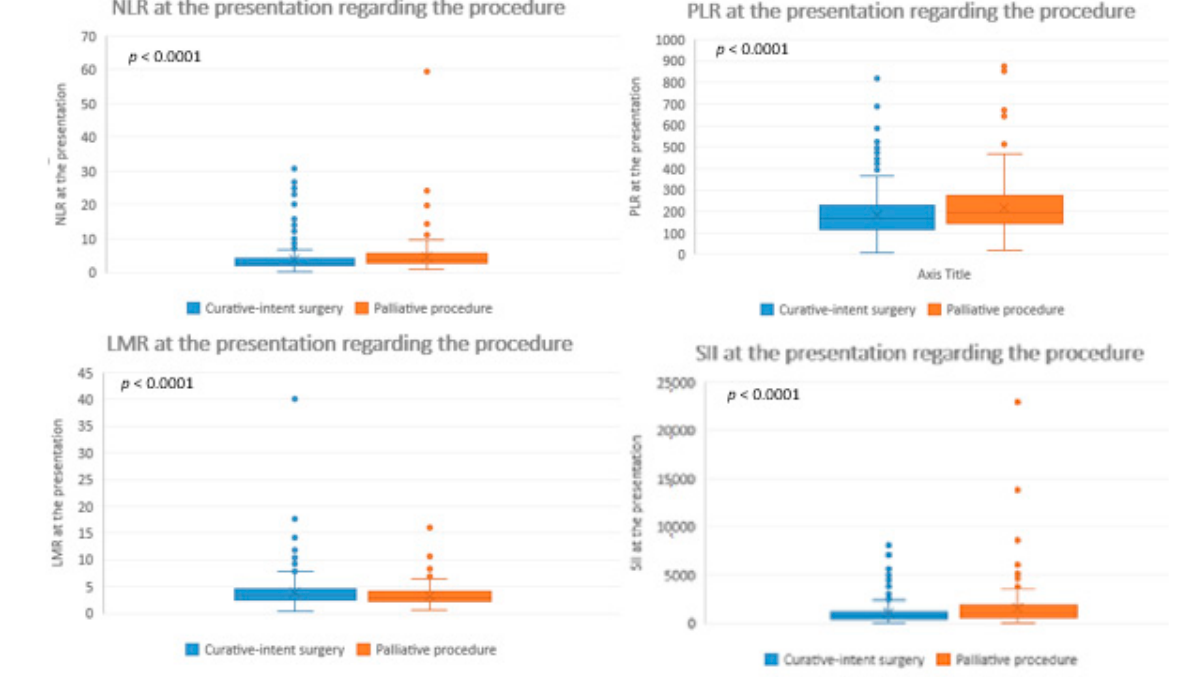
Figure 2. Inflammatory biomarkers at presentation regarding the procedure. NLR = neutrophil-to-lymphocyte ratio; PLR = platelet-to-lymphocyte ratio; LMR = lymphocyte-to-monocyte ratio; SII = systemic immune-inflammation index.